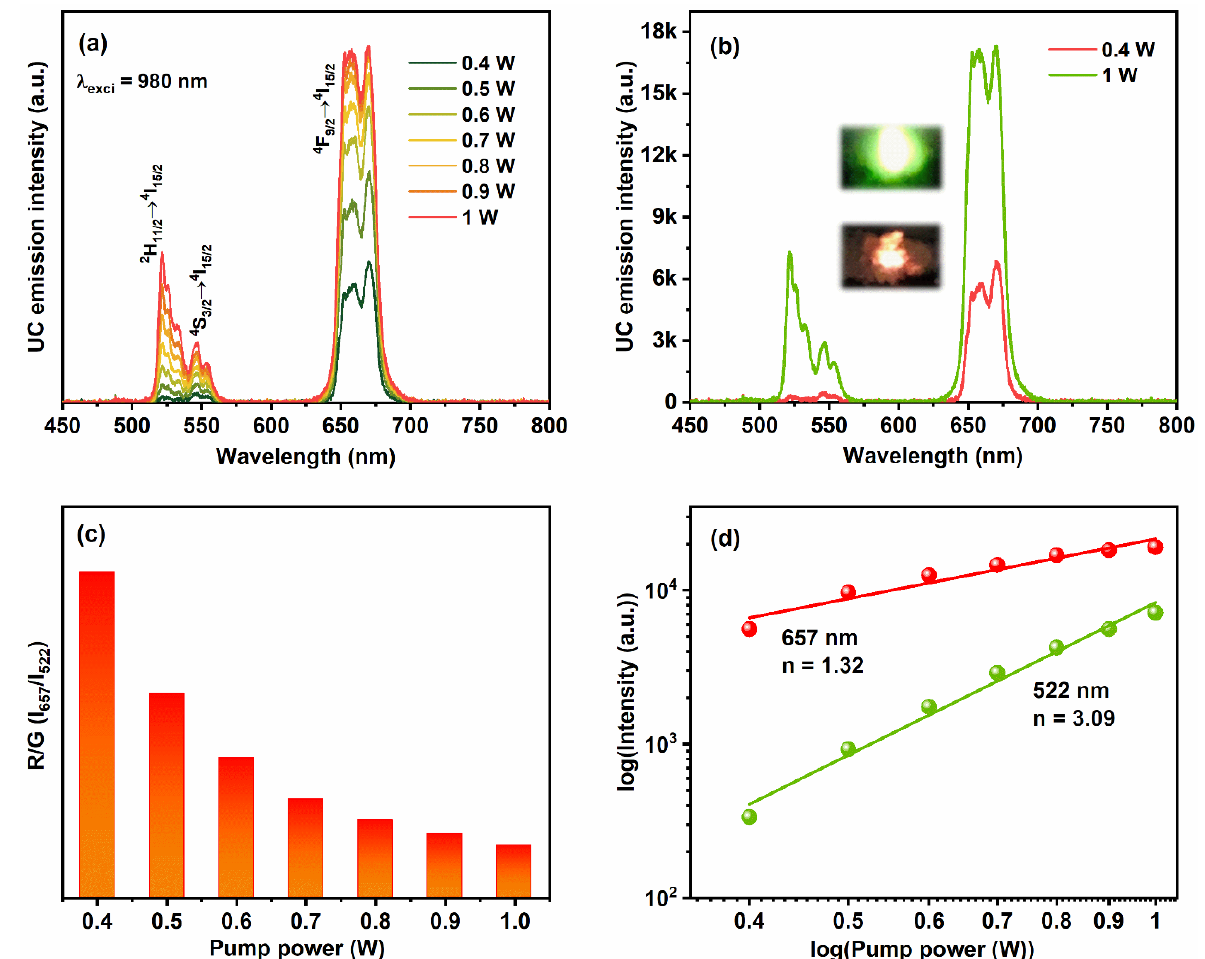
Figure 5. ( a ) UC luminescence spectra of YVO 4 :Er 3+ /Yb 3+ UC-MHNSPs as a function of incident pump power under 980 nm excitation, ( b ) comparison between the emission spectra of YVO 4 :Er 3+ /Yb 3+ UC-MHNSPs at low and high excitation powers and the insets show the corresponding digital photos. ( c ) R/G versus input pump power and ( d ) logarithmic plots of input laser pump power versus green and red emission intensities.